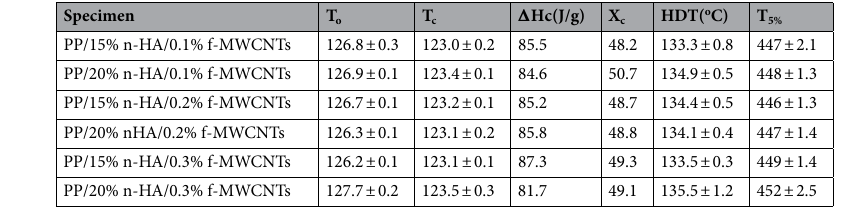
Table 1. Specimen investigated thermal and crystallization